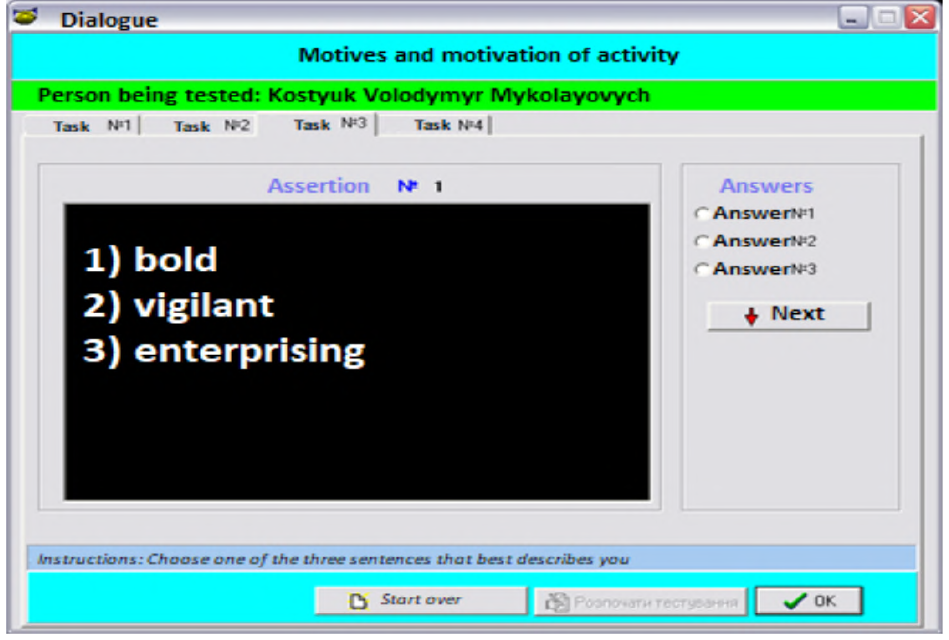
Figure 83: Presentation of paper